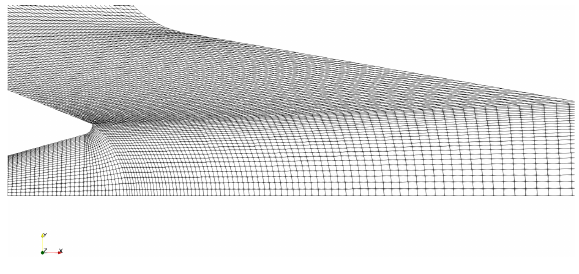
Figure 4. Detail of mixing region.